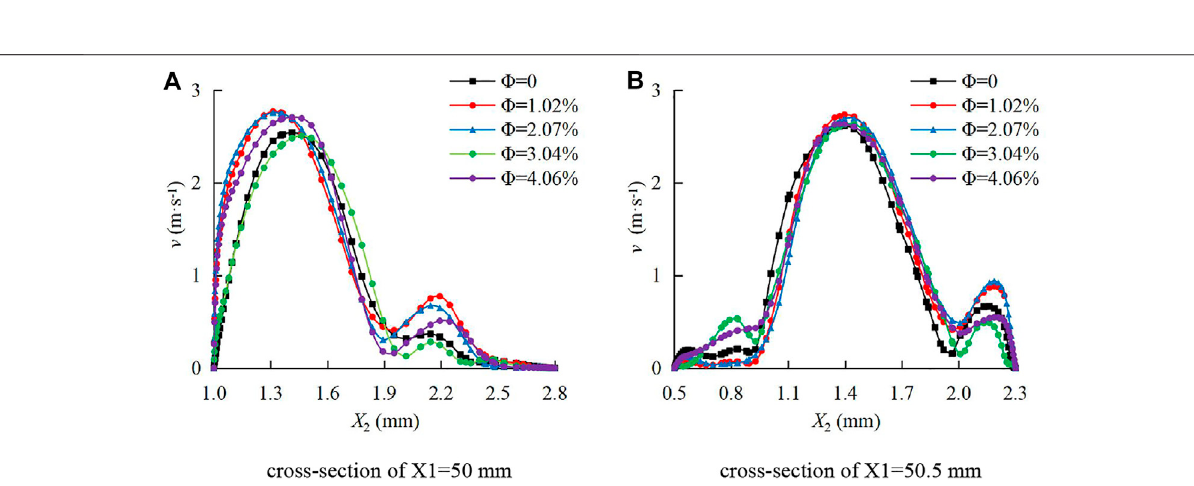
Frontiers in Physics |